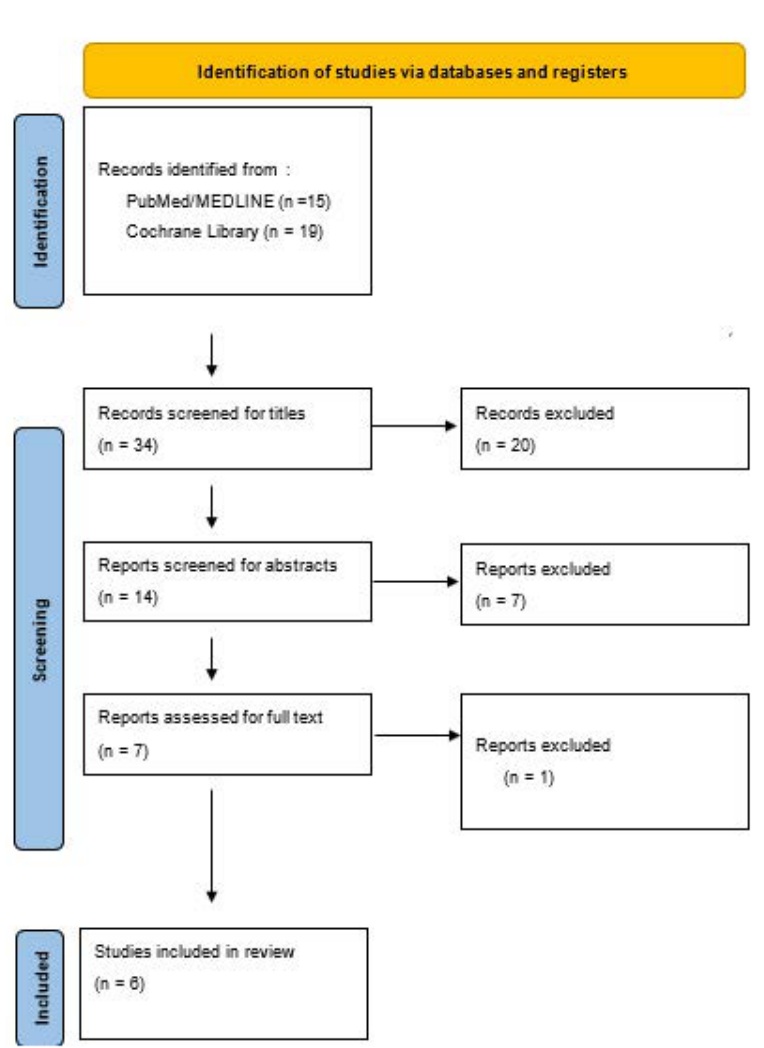
Table 3. PRISMA Diagram of Screening Process .